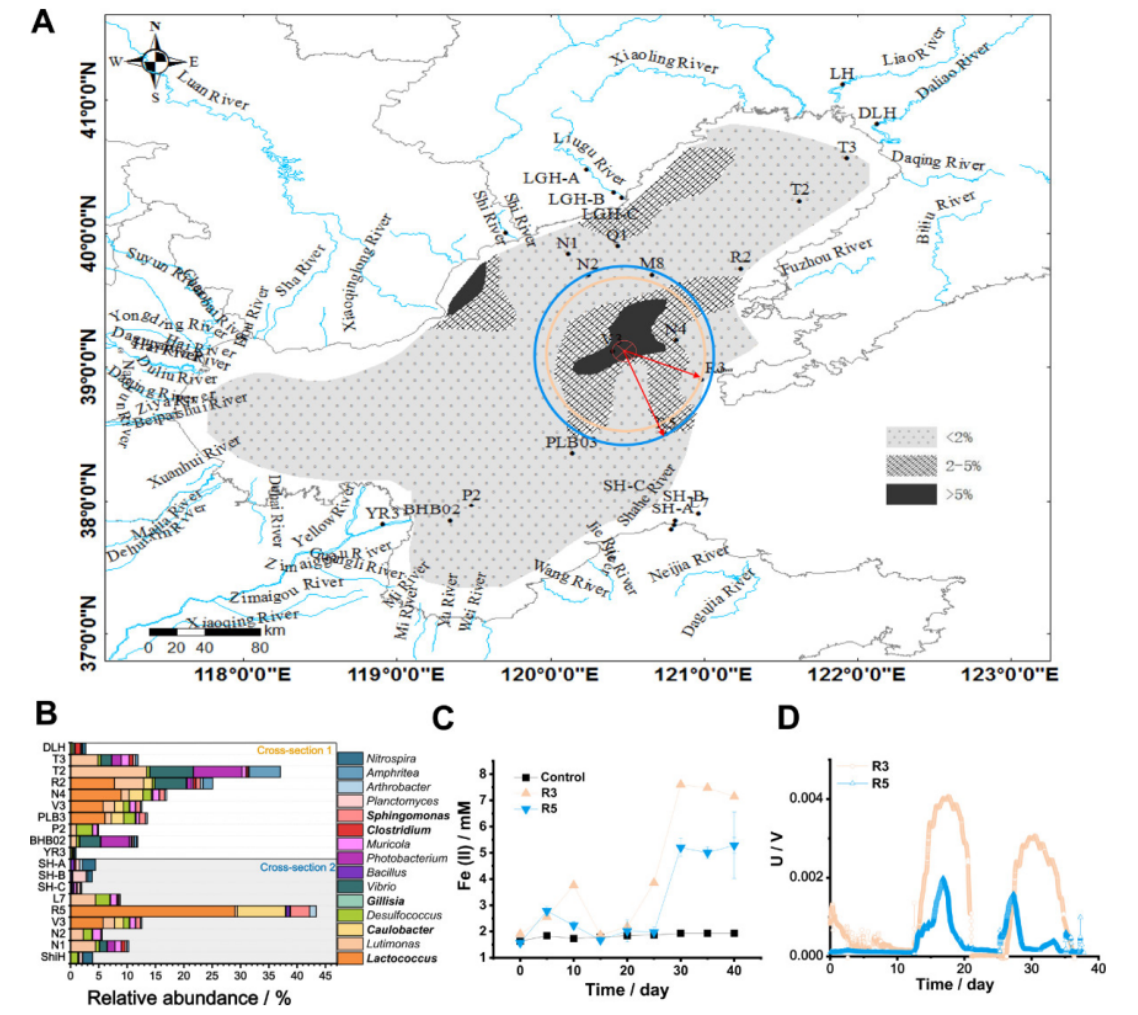
Figure 5. Presence of magnetite accumulation center affected dissimilatory iron reducing microor- ganism (DIRB) distribution and extracellular electron transfer process. ( A ) Maps showing sediment sample sites from two standard oceanic sections through the Bohai Sea, section 1 (DLH, T3, T2, R2, N4, V3, PLB3, P2, BHB02, YR3) and section 2 (SH-A, SH-B, SH-C, L7, R5, V3, N2, N1, SH). Central area of magnetite exposure (red circle) (120.4 ◦ E, 39 ◦ N) and percentage of magnetite showed in shadow. R3 and R5 with different horizontal distances (red arrows). ( B ) Relative abundances of the top 15 bacterial taxa at genus level of sample sites from two standard oceanic sections. Bold indicates the significant difference ( p < 0.05) tested by correlation analysis between genera and geographical distance to the center of magnetite in Table 3. ( C ) Production of iron (II) in sediments of sample sites in R3 and R5 cultured with amorphous iron. ( D ) Voltage-time curves of air-cathode MFCs based on enrichment culture from R3 and R5. An external resistor of 1000 Ω was loaded between the anode and cathode. Three reactors were operated for each inoculum and the experiments were repeated three